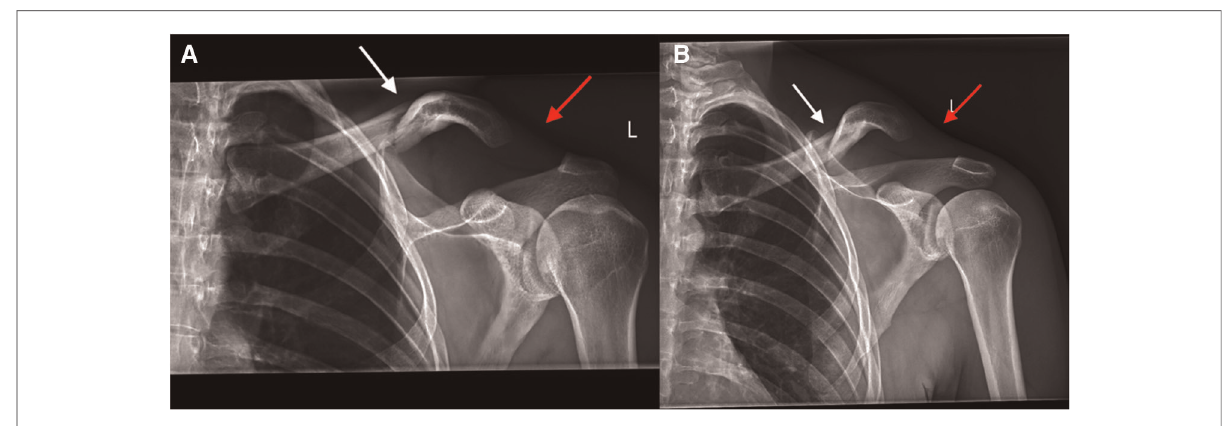
FIGURE 2 Radiographs demonstrating midshaft clavicle fracture with associated acromioclavicular joint dislocation (white arrow demonstrating the